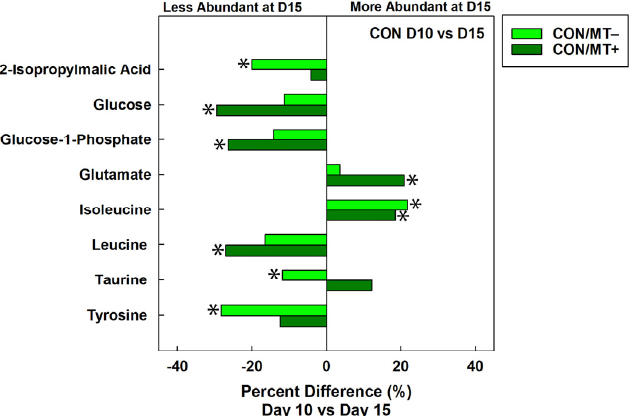
Figure 6. Average percent difference in discriminated metabolites in cecal digesta between broiler chicks that were administered an unamended starter diet (CON) and received a microbiota transplant (MT+) or buffer alone (MT–). Samples were analyzed 10 days post-hatch (D10) and 15 days post-hatch (D15). Metabolites that were altered ( p ≤ 0.050) according to Univariate Mann–Whitney analysis are denoted with an asterisk.